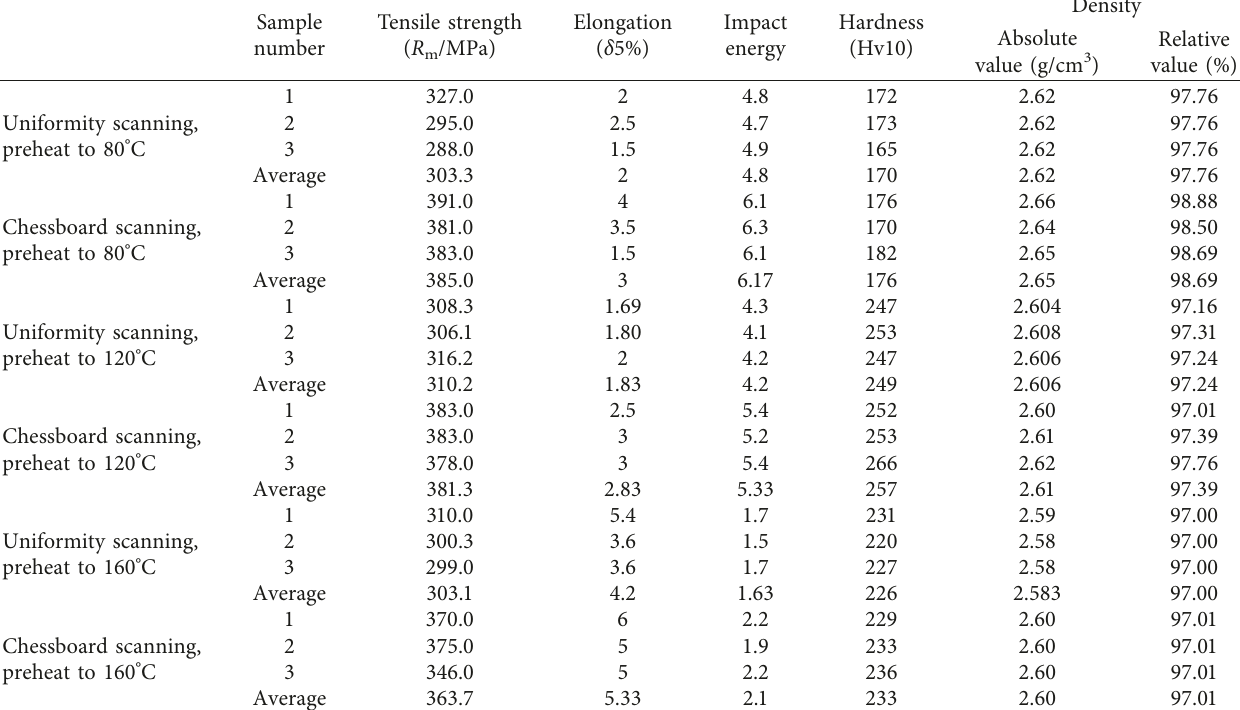
Table 3: Mechanical properties of SLM AlSi10Mg